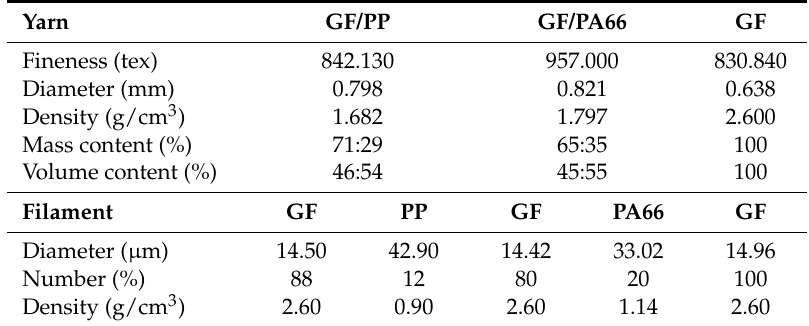
Table 1. Yarn and corresponding filament characteristics.